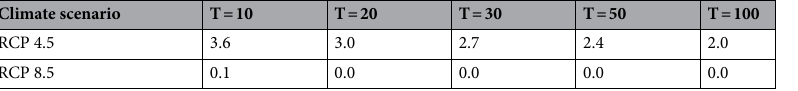
Table 1. Change of annual maximum daily precipitation with five return periods (once in T years) during the period 1991–2050 in Xiongan New Area based on climate projection data (unit: